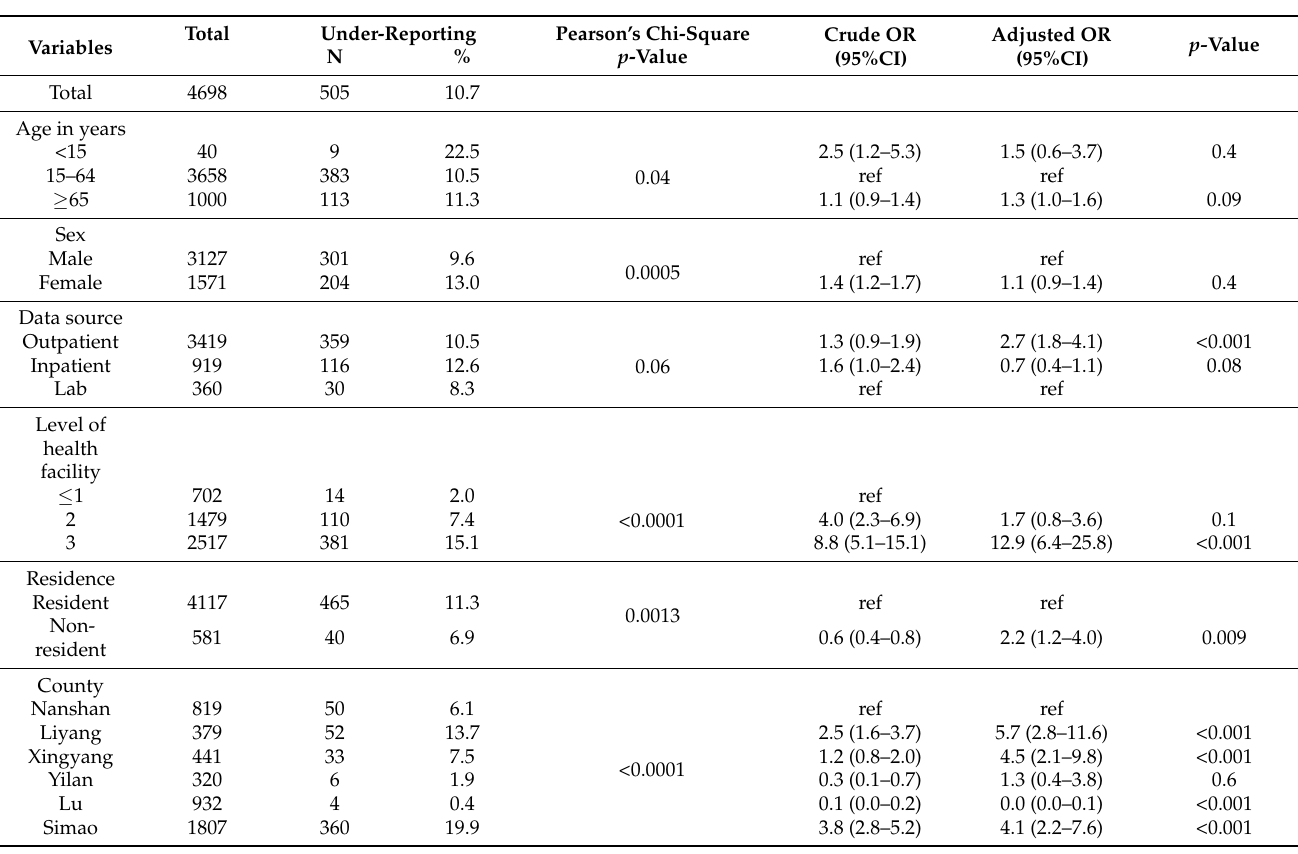
Table 3. Factors associated with under-reporting to IDRS among diagnosed TB patients in six counties in 2016.